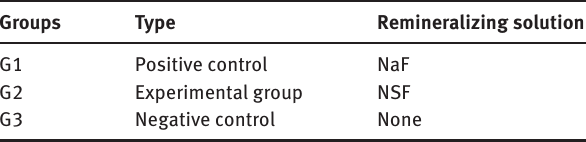
Table 1: Description of the studied